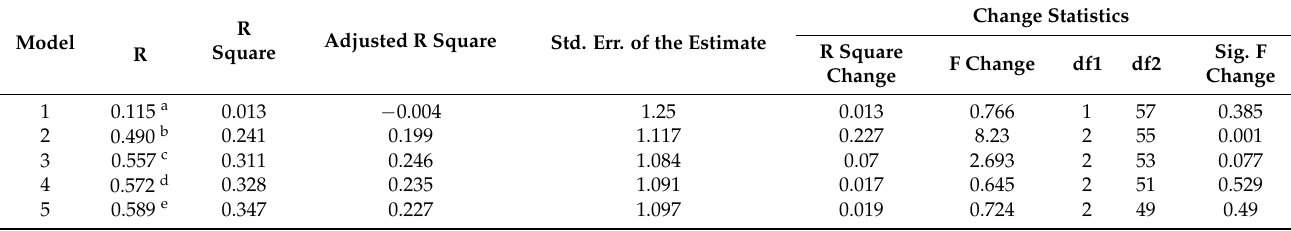
Table 2. Multivariate analysis of structural